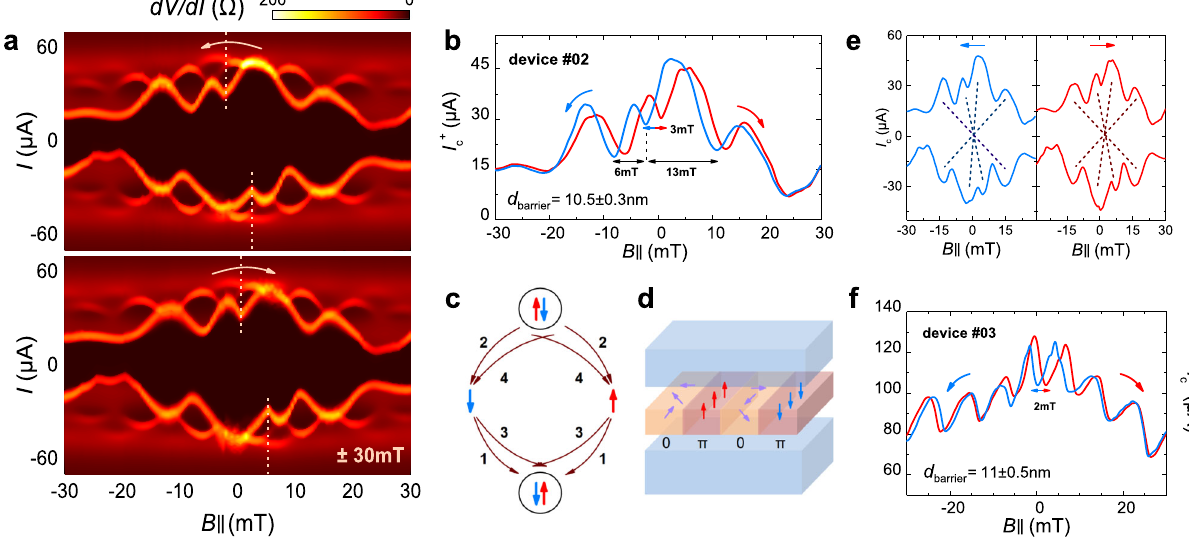
Fig. 4 Unconventional Fraunhofer patterns as evidence of π phase coupling. a 0- π junction like I c oscillation patterns of device #02 with the magnetic fi eld starts from ±30 mT at 0.1 K. Its barrier thickness is ~10.5 nm. The yellow dashed lines mark the valley positions of the central minimum of I c to depict a 0- π junction behavior. b Hysteresis of I c + of device #02. The Δ B max value is 3 mT estimated from the valley positions in the center. The difference of fi eld widths around this valley indicates an asymmetric local magnetization of the barrier. c Origin of a π phase through the magnetic tunneling of Cooper pairs. The reversal of the spin-order involves the fourth-order co-tunneling process. d Illustration of a junction area with several π segments (perpendicular magnetizations) and 0 segments (tilted or parallel magnetizations). e Comparisons of I c at the positive and negative bias of device #02 (left and right: opposite sweeping branches) to exclude the in fl uence of trapped vortex. f Another 0- π junction signature of device #03 with a ~11-nm-thick barrier. The fi eld starts from ±50 mT at 0.1 K, giving the Δ B max value of 2